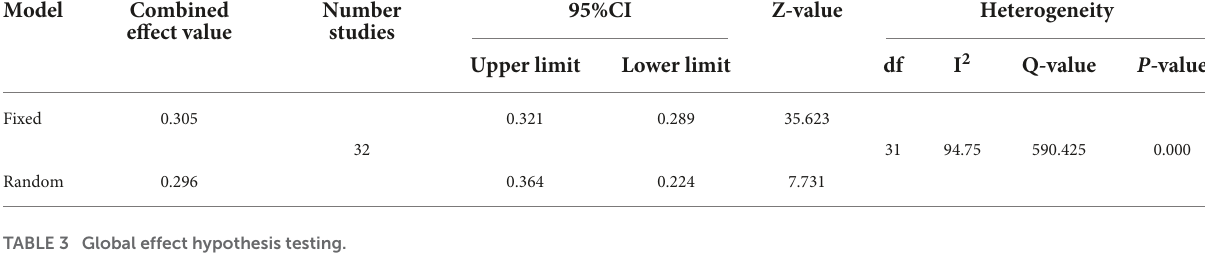
TABLE 2 Heterogeneity test.